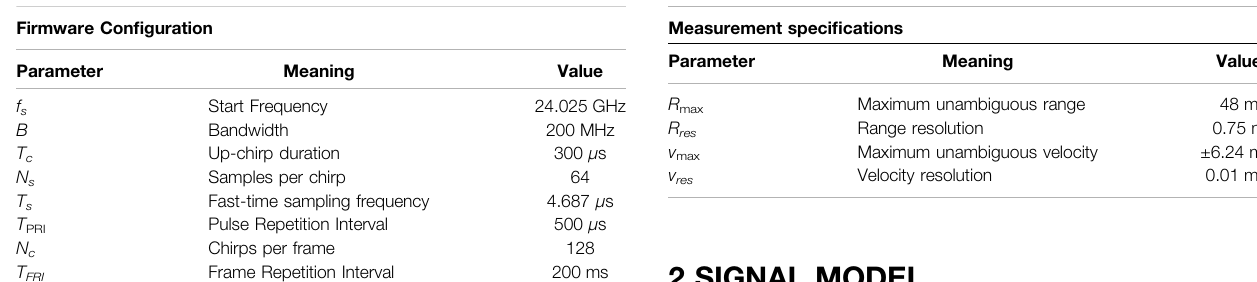
TABLE 1 | Firmware Con fi guration. TABLE 2 | Measurement speci fi cations.